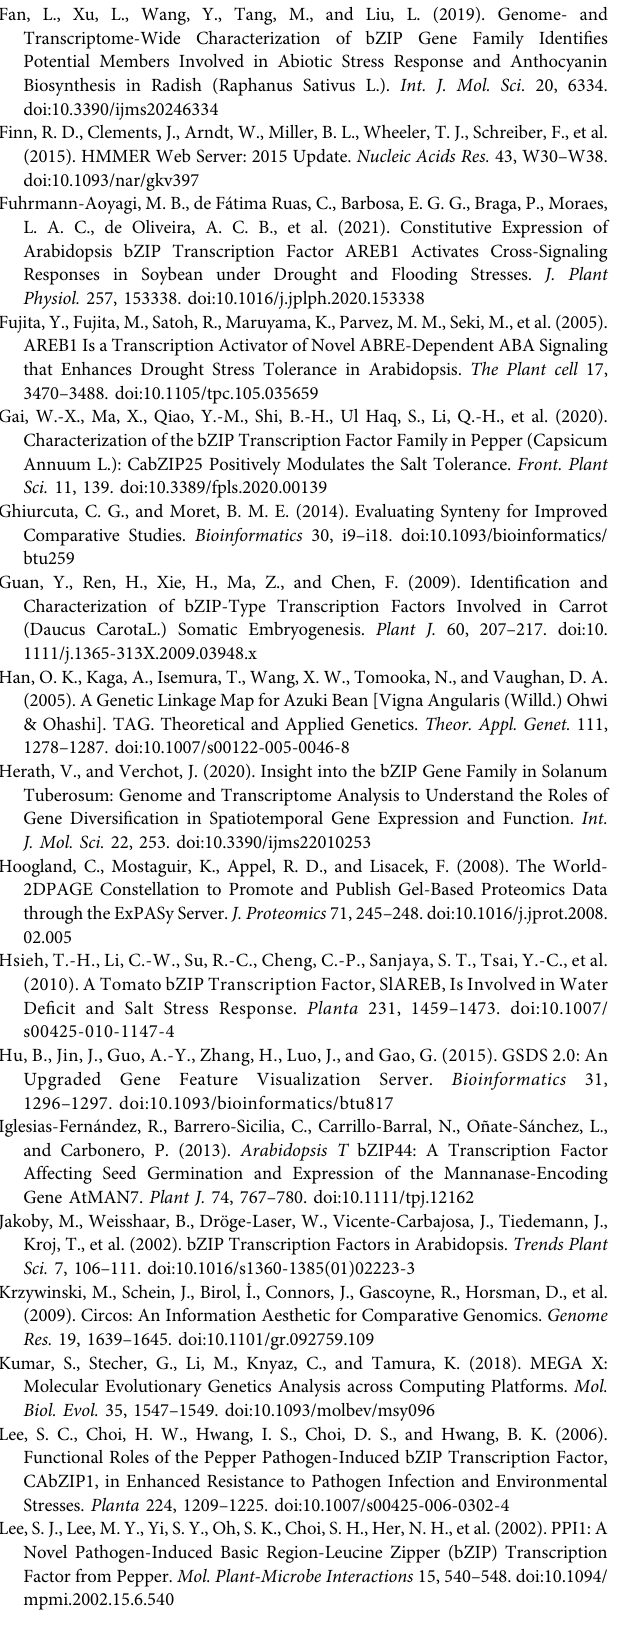
TabZIP Genes. BMC Genomics 16, 976. doi:10.1186/s12864-015-2196-7 Liang, Y.,Xia,J.,Jiang,Y.,Bao, Y.,Chen,H.,Wang,D.,etal.(2022).Genome-Wide Identi fi cation and Analysis of bZIP Gene Family and Resistance of TaABI5 (TabZIP96) under Freezing Stress in Wheat ( Triticum A ). Int. J. Mol. Sci. 23, 2351. doi:10.3390/ijms23042351 Liao, Y., Zou, H.-F., Wei, W., Hao, Y.-J., Tian, A.-G., Huang, J., et al. (2008). Soybean GmbZIP44, GmbZIP62 and GmbZIP78 Genes Function as Negative Regulator of ABA Signaling and Confer Salt and Freezing Tolerance